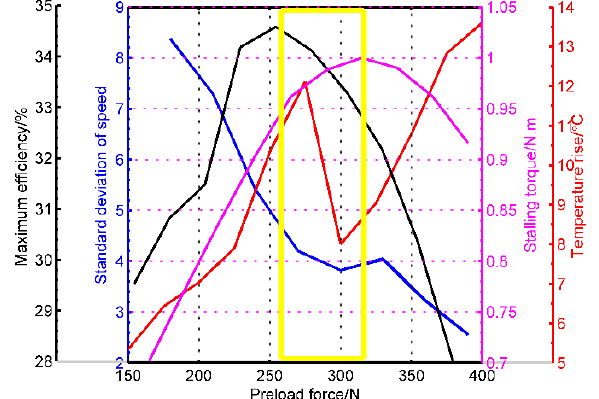
Figure 9. The diagram which interprets the optimization rule of the preload force.